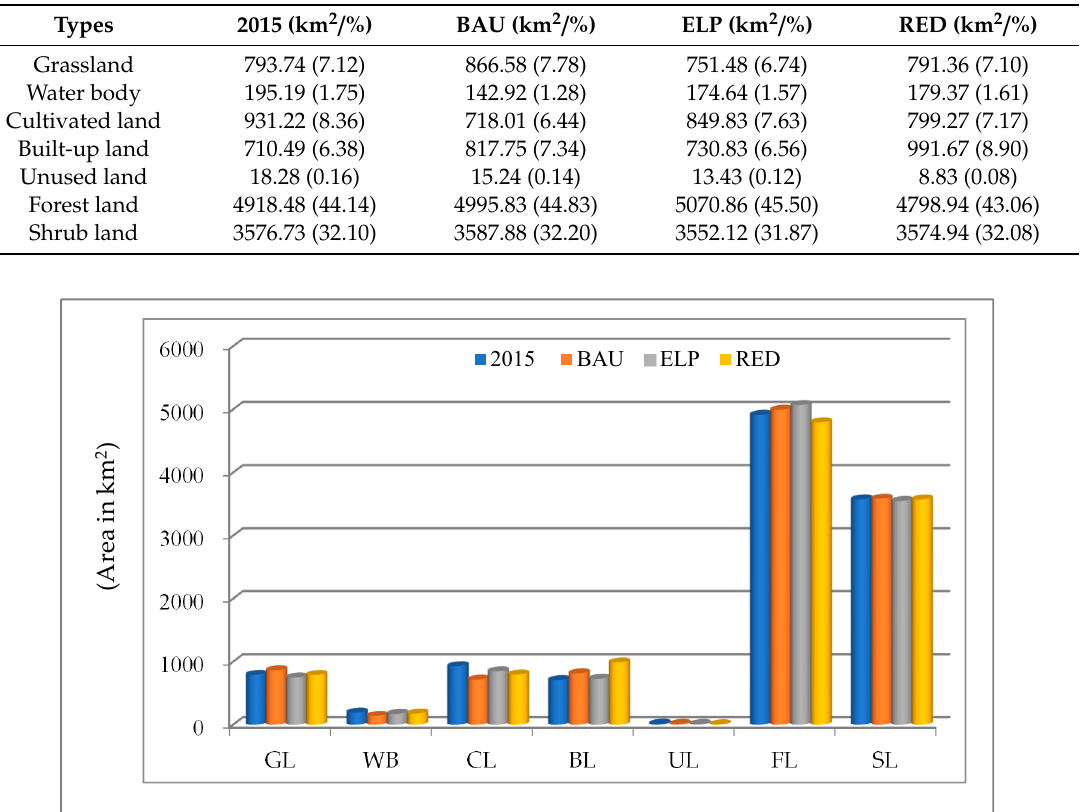
Figure 2. Land-use changes from 2015 to 2030, under the BAU, RED, and ELP scenarios in the ecological conservation area; BL (built-up land), CL (cultivated land), FL (forest land), SL (shrub land), UL (unused land), WB (water body), and GL (grass land). Table 2. Land-use area (km 2 ) and percent area (%) for each land-use type, from baseline year 2015 to 2030, under the BAU, ELP, and RED scenarios in the ecological conservation area.